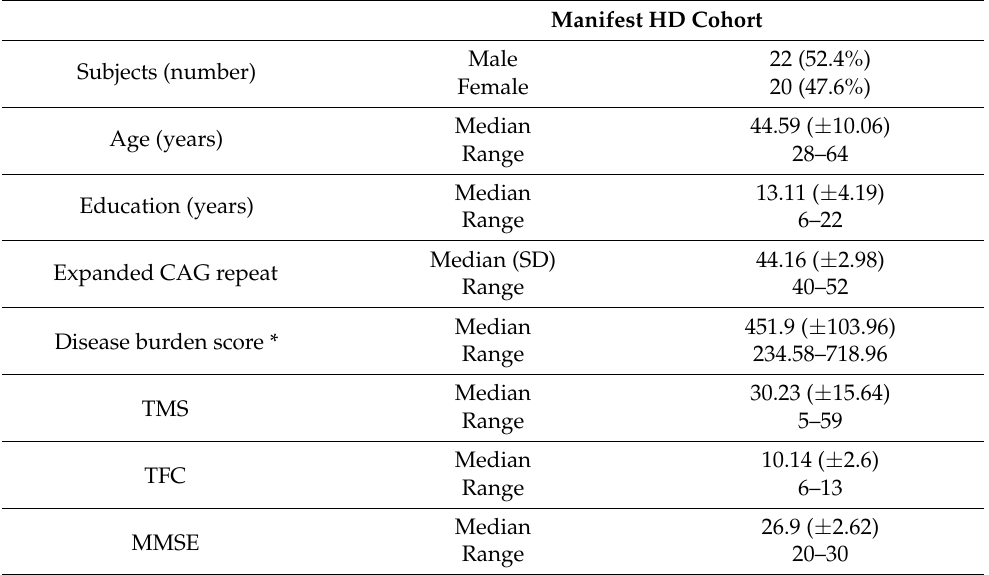
Table 1. Patients’ scores across the outcome